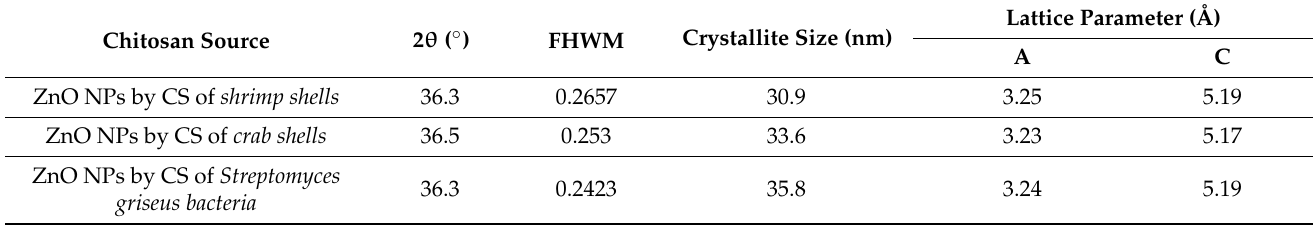
Figure 2. The XRD diffraction pattern of the synthesized ZnO NPs from chitosan of shrimp shells, crab shells and Streptomyces griseus bacteria. Table 1. The XRD calculations of ZnO NPs from chitosan of shrimp shells , crab shells, and Streptomyces griseus bacteria .